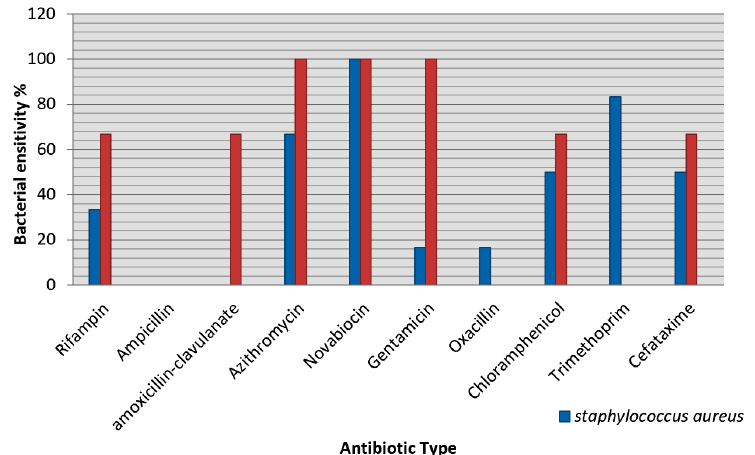
Fig. 1. Distribution of Antibiotics sensitivity of Gram Positive Bacteria Isolated from Children with